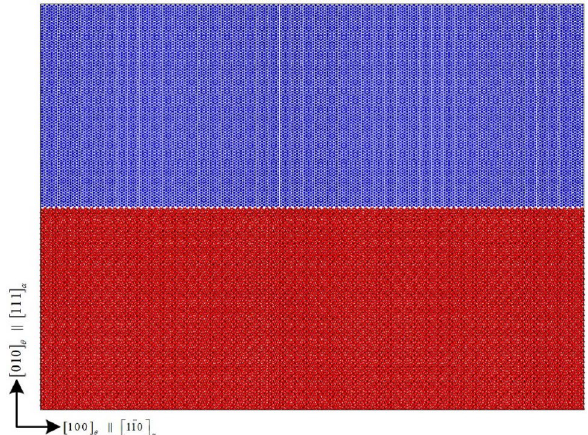
Figure 6. Ferrite/cementite interface model.